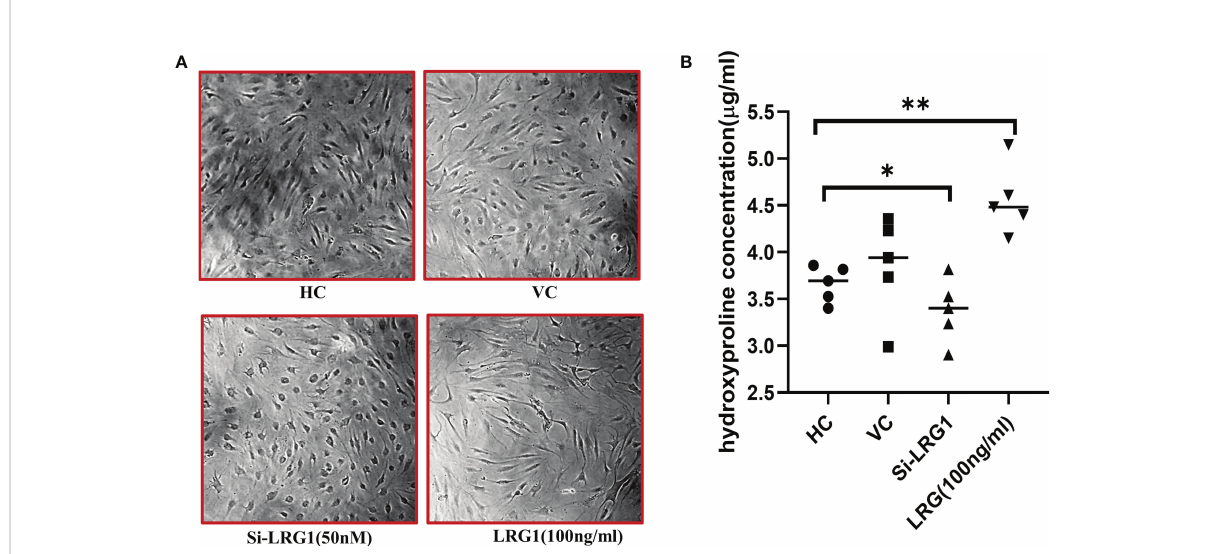
FIGURE 5 Hydroxyproline assay after stimulation/knockdown of LRG1. Microscopy images were taken at ×10 magni fi cation using Nikon Eclipse 650 (NIKON, Tokyo, Japan). The optical density of hydroxyproline was measured with a spectrophotometer (Molecular Devices, San Jose, CA, USA). Graphs were generated and the statistical analysis carried out using GraphPad Prism (version 8.4.686). Data are presented as the mean ± standard deviation (SD). One-way ANOVA was used to compare the data among groups to show statistical signi fi cance. (A) Increased extracellular matrix observed in primary synovial cells from patients with OA after stimulation using pure LRG1 (100 ng/ml); a reverse effect was observed morphologically after silencing the LRG1 gene using 50 nM siRNA compared to the non-treated group. (B) Level of collagen measured with the hydroxyproline assay. The level of hydroxyproline indicated a 1.3-fold increase in the stimulated (with 100 ng/ml LRG1) group compared to the control group, with 0.74 and 0.9-fold decreased levels of hydroxyproline in the knockdown (50 nm si-LRG1) group compared to the LRG1-treated and the non-treated group, respectively. * p ≤ 0.05; ** p ≤ 0.01. LRG1 , leucine-rich alpha-2 glycoprotein; OA ,